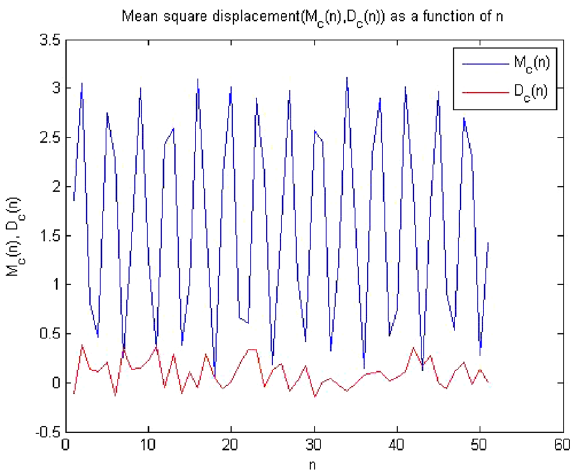
Figure 15. Plot of MSD vs time have periodicity as there is no asymptotic growth.